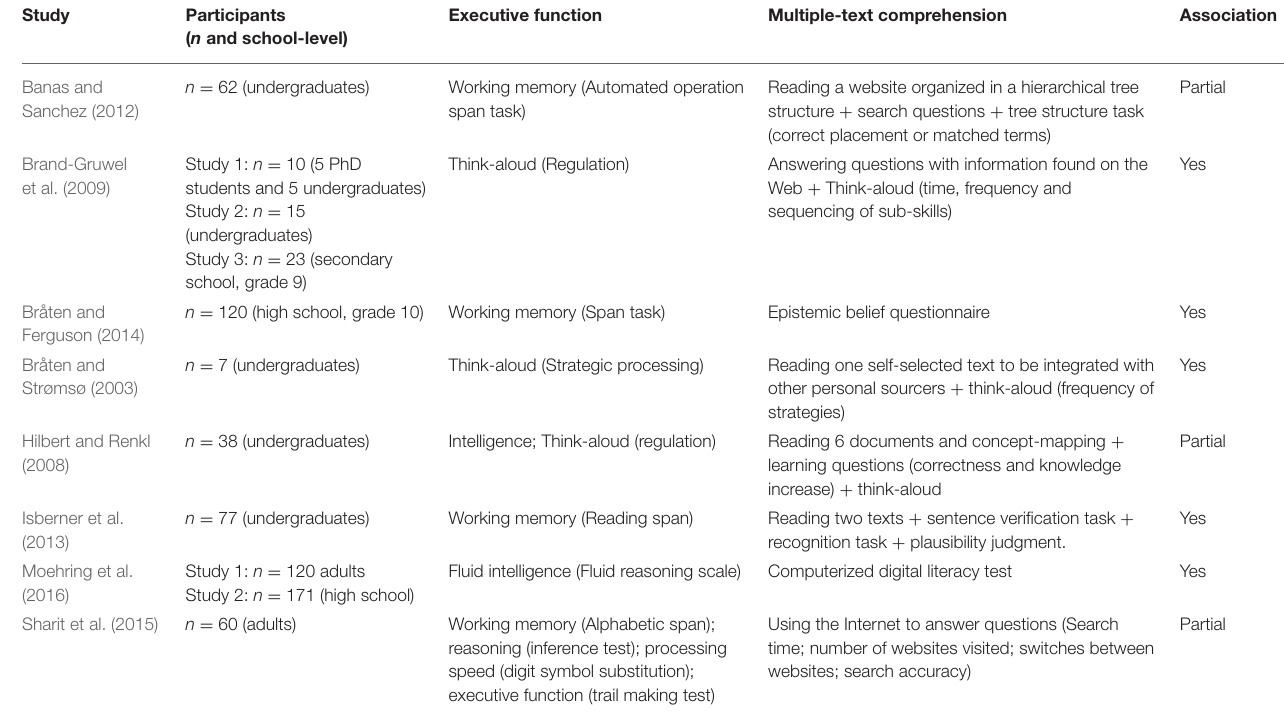
TABLE 2 | Studies presenting indirect evidence on the association between executive functions and multiple-text comprehension.